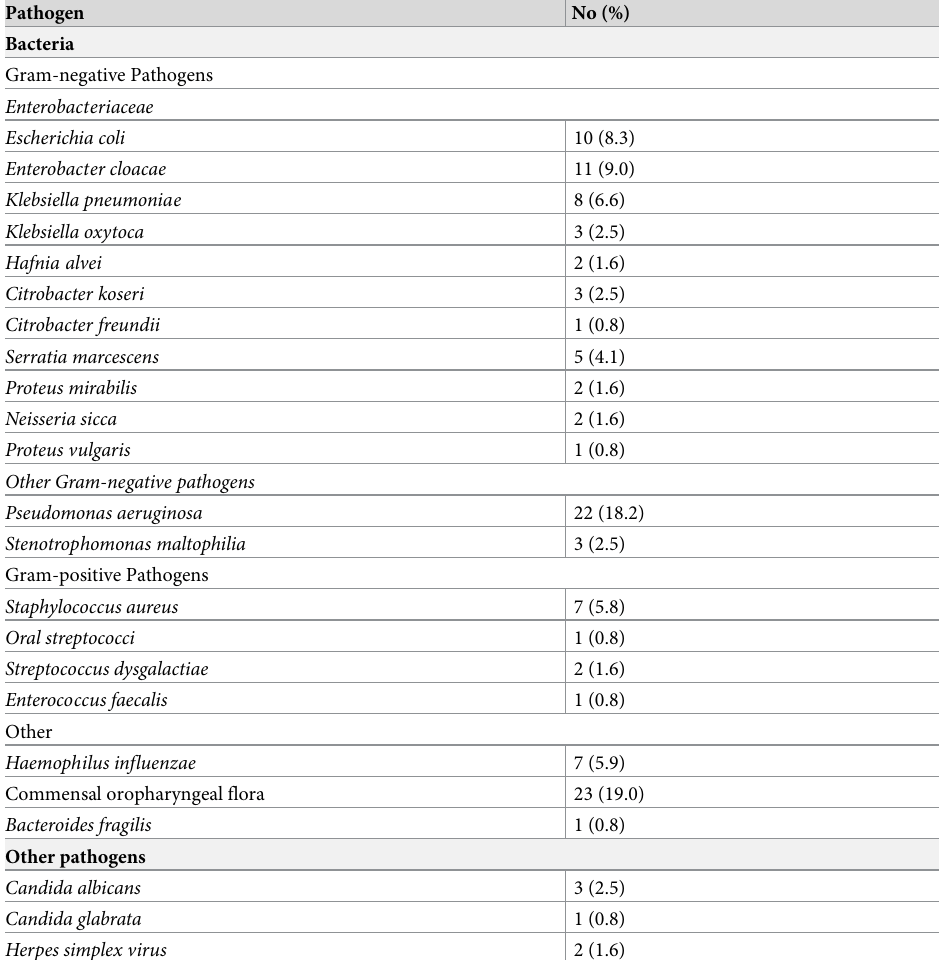
Table 2. Pathogens isolated from respiratory